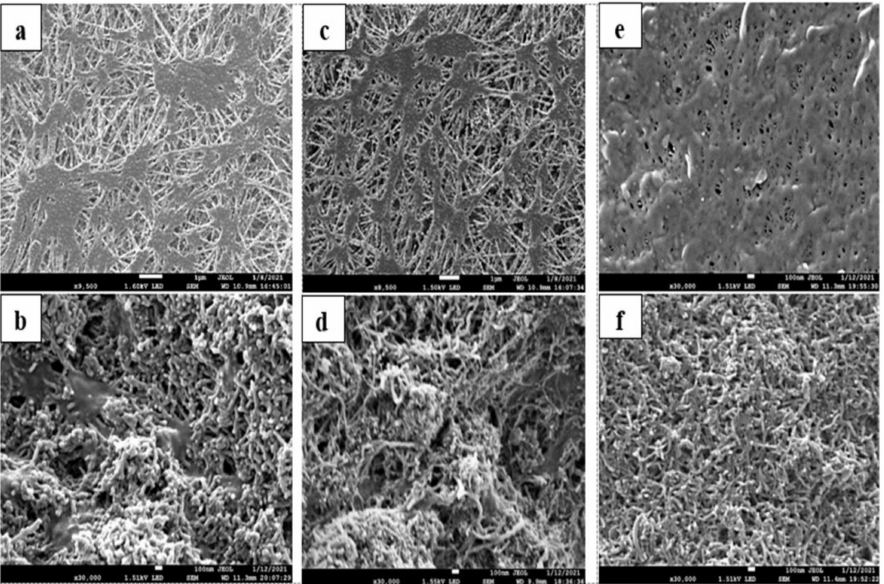
Figure 2. SEM images of PTFE and PVDF unmodified membranes and CNIM membranes: ( a , b ) unmodified PTFE (0.1 µ m) and CNIM-3; ( c , d ) unmodified PTFE (0.22 µ m) and CNIM-6; ( e , f ) unmodified PVDF (0.22 µ m) and CNIM-6.